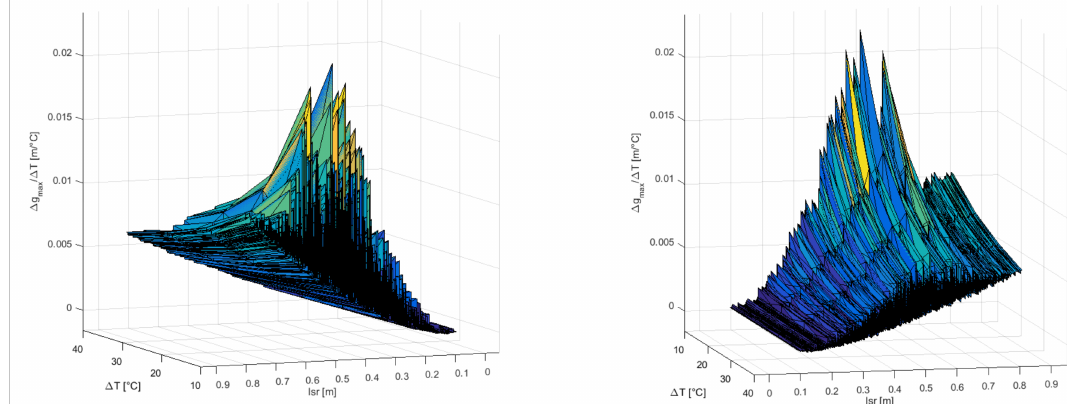
Figure 7. Maximum sensitivity of the algorithm concerning the transformer oil-temperature change ∆ g max/ ∆ T over the mean distance between the PD and AE sensor l sr and temperature change ∆ T , in the first